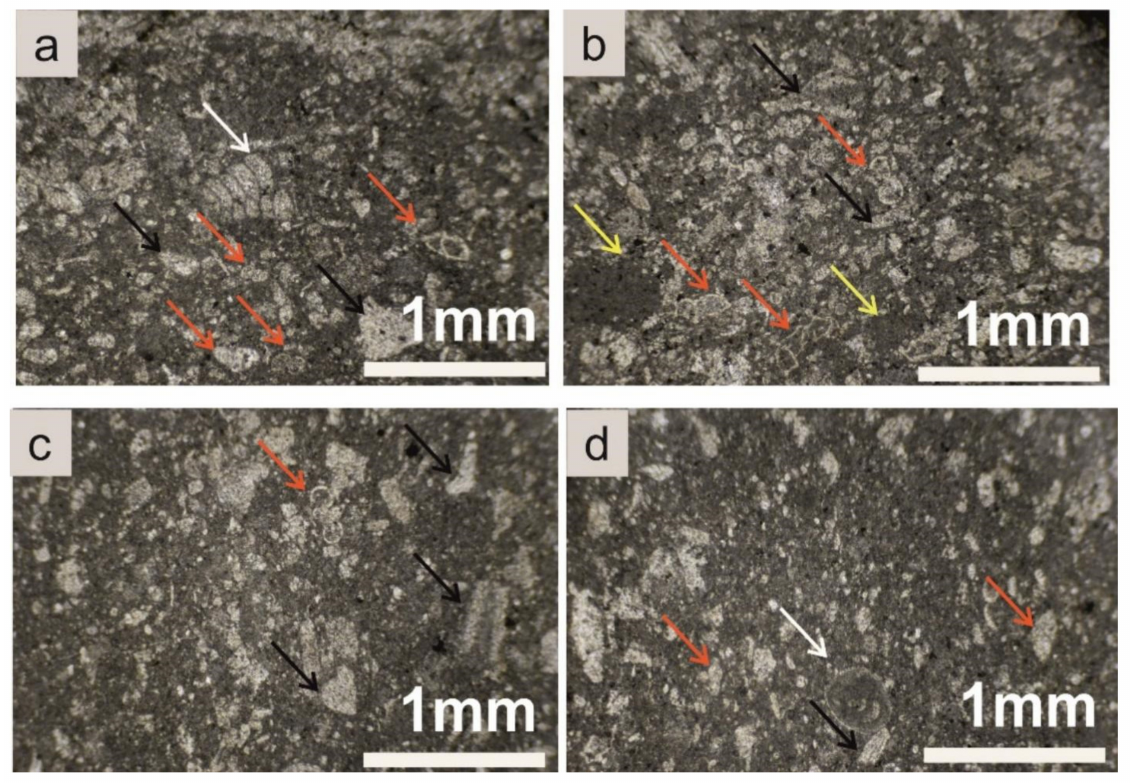
Figure 7. Microfacies typeF2: Polymict clast supported microbreccia of Maastrichtian age. ( a ) planktic foraminifera (red arrow), bioclasts’ debris (black arrow), benthic foraminifera (white arrow), sample K13, ( b ) planktic foraminifera (red arrow), bioclasts’ debris (black arrow), micritic clasts (yellow arrow), sample K13, ( c ) planktic foraminifera (red arrow), bioclasts’ debris (black arrow), sample K6, ( d ) recrystallized planktic foraminifera (red arrow), bioclasts’ debris (black arrow), benthic foraminifera (white arrow), sample K2.